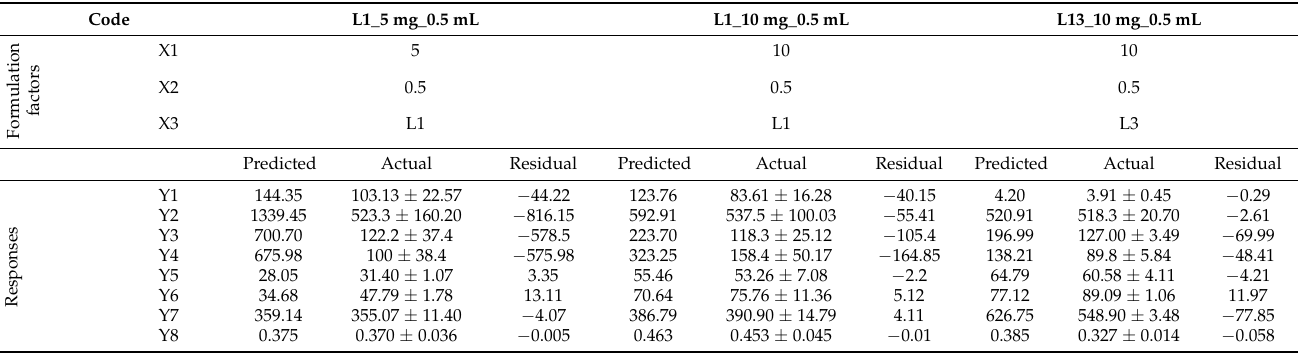
Table 5. Results of the DoE validation